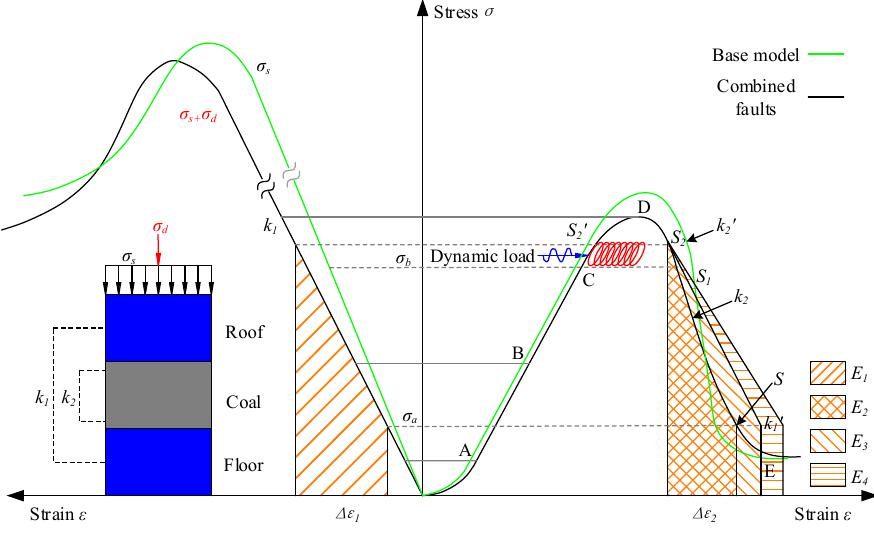
Figure 8. Schematic diagram of rock burst mining near the combined faults.